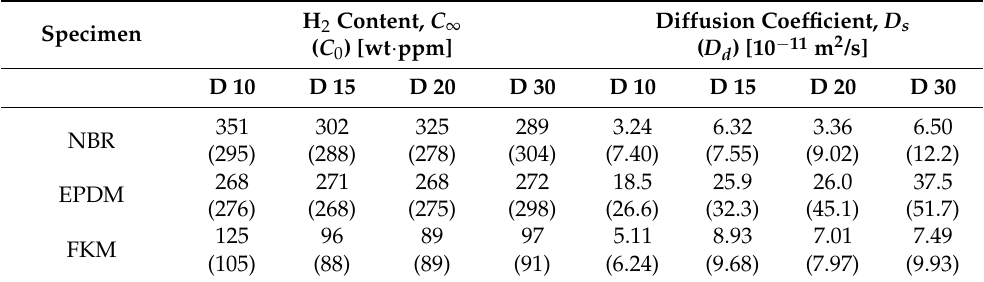
Table 2. H 2 content and diffusivity for the sorption (desorption) process for spherically shaped NBR, EPDM, and FKM at 5.75 MPa and 296